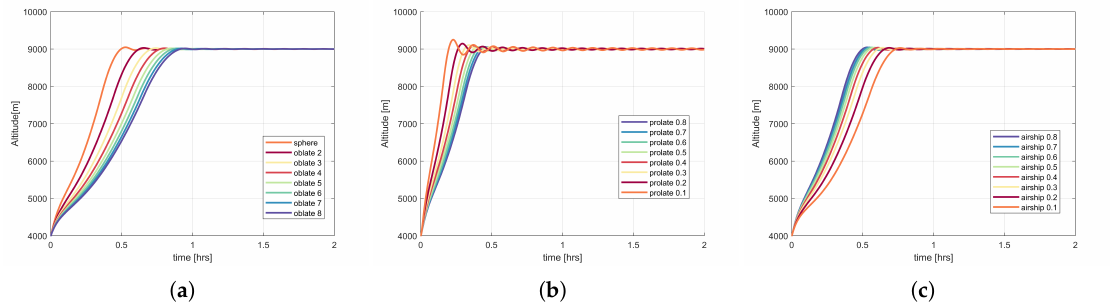
Figure 10. Altitude variation of the SP balloons for different shapes with varying fineness ratios f in order to find the stable fineness ratio on Mars ( a ) oblate ( f : 2–8) ( b ) prolate (0.1–0.8) ( c ) airship